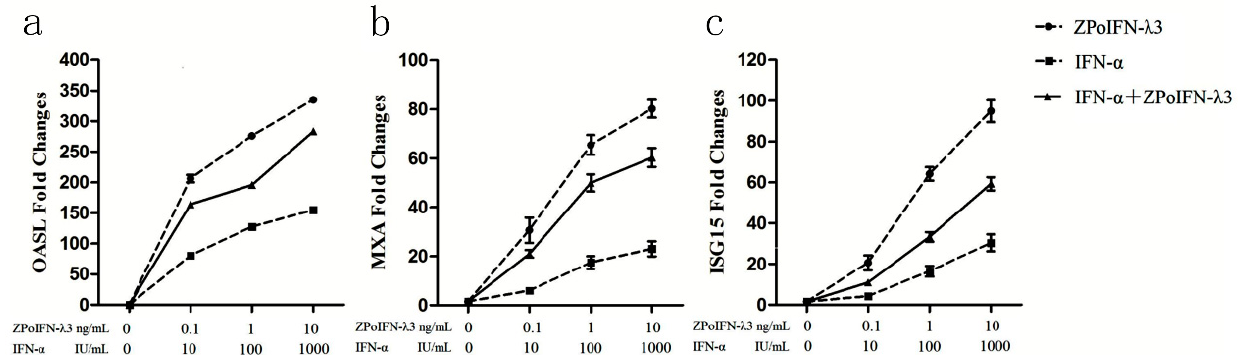
Figure 3. Expressions of ISGs induced by IFN- α , IFN- λ 3 and IFN- α + IFN- λ 3 in IPEC-J2 cells. IPEC-J2 cells were stimulated with either one IFN alone or in combination with two IFNs for 24 h, and the mRNA levels of OASL ( a ), MxA ( b ) and ISG15 ( c ) were measured by a relative RT-qPCR. The results were normalized by the β -actin levels of each sample. Dotted lines: IFN- α ( ■ ) or IFN- λ 3 ( ● ) used individually; continuous line: IFN- α and IFN- λ 3 ( ▲ ) used in combination. Data were presented as mean ± SEM ( n = 3).